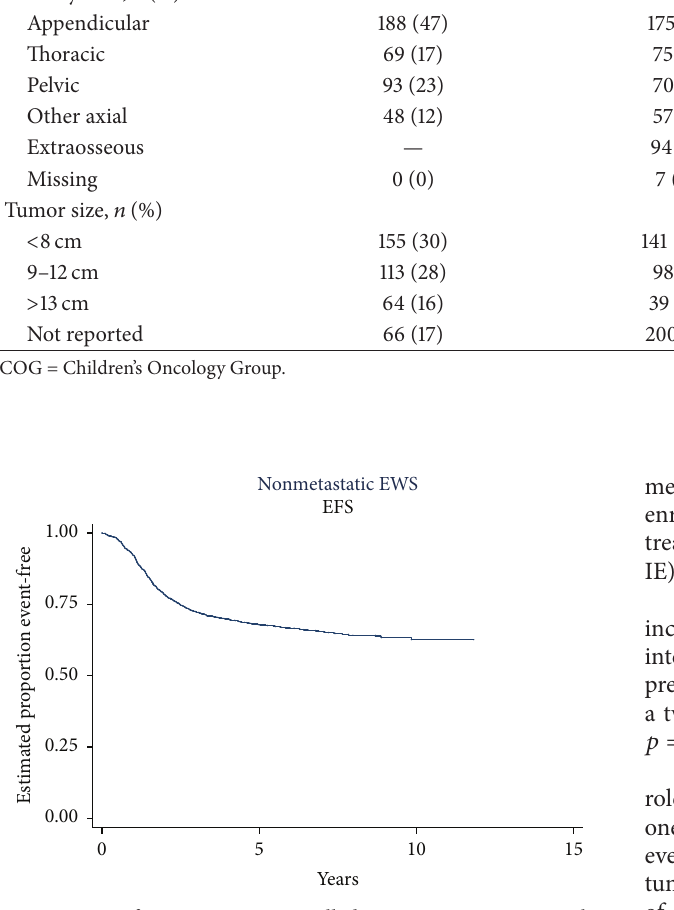
Figure 2: EFS for 1444 patients enrolled in consecutive COG trials. The 5-year EFS for the group was 68.32% ± 1.3%. EFS = event-free survival; COG = Children’s Oncology